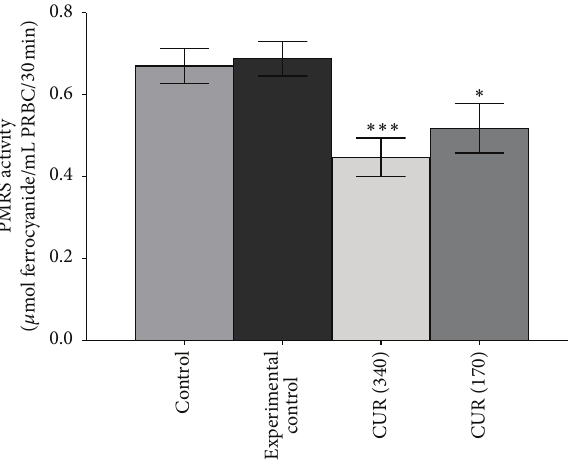
Figure 2: In vivo effect of curcumin (340mg/kg b.w. as CUR 340 and 170mg/kg b.w. oral CUR 170) on healthy rat erythrocytes membrane PMRS activity. PMRS activity expressed in terms of 𝜇 mol ferrocyanide/mL PRBC/30min. Values represent mean ± SD. Control represents rats receiving no treatment/supplementation; experimental control: rats were supplemented with 0.9% NaCl solution through oral